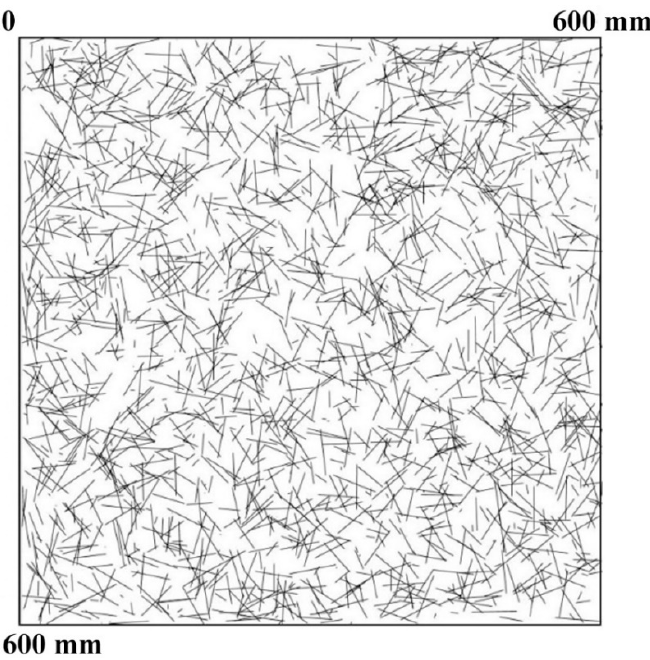
Figure 8. A computer simulation of fibre spacing based on the three-parameter generalised beta distribution at the depth of 30 mm. Materials 2019 , 12 , x FOR PEER REVIEW